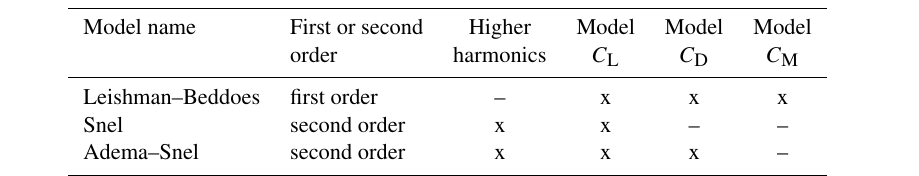
Table 1. Properties of the discussed dynamic stall models.